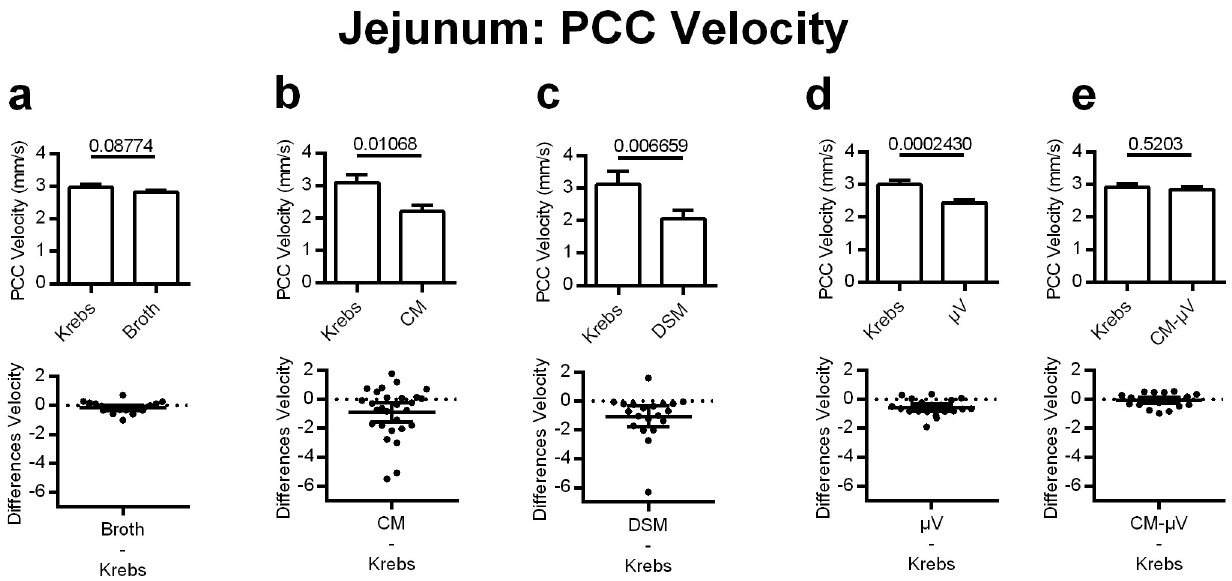
Fig 2. Effects of adding DSM, DSM derived microvesicles μ V ( μ V) or media on PCC velocity for mouse jejunal segments, in vitro . Upper panels: bar graphs showing means and standard errors. c) DSM (N = 20), b) conditioned medium (CM) (N = 28) and d) DSM μ V reduced PCC velocity (N = 20). Neither (a) broth (N = 20) nor conditioned medium minus μ V (e) (CM- μ V) (N = 20) altered PCC velocity. P values derived from paired t-tests are given above horizontal bars. Lower panels: individual value plots of difference (treatment-control Krebs) with 95% confidence intervals for each matching graph in upper row. All subsequent figures show the same relationships between upper and lower panels. Significance determined when p < 0.05.